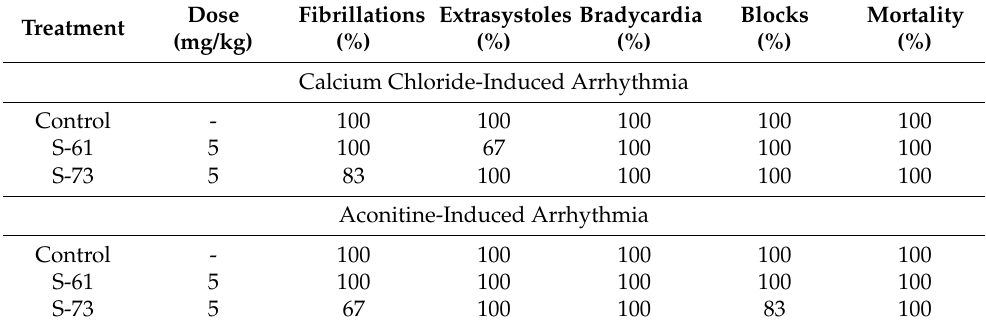
performed for 15 min after the iv injection of adrenaline (20 μg/kg), calcium chloride (140 mg/kg), or aconitine (20 μg/kg) , i.e., during the first 2 min, at 5th, 10th, and 15th min. Results are presented blocks, mortality); n = 6 rats.